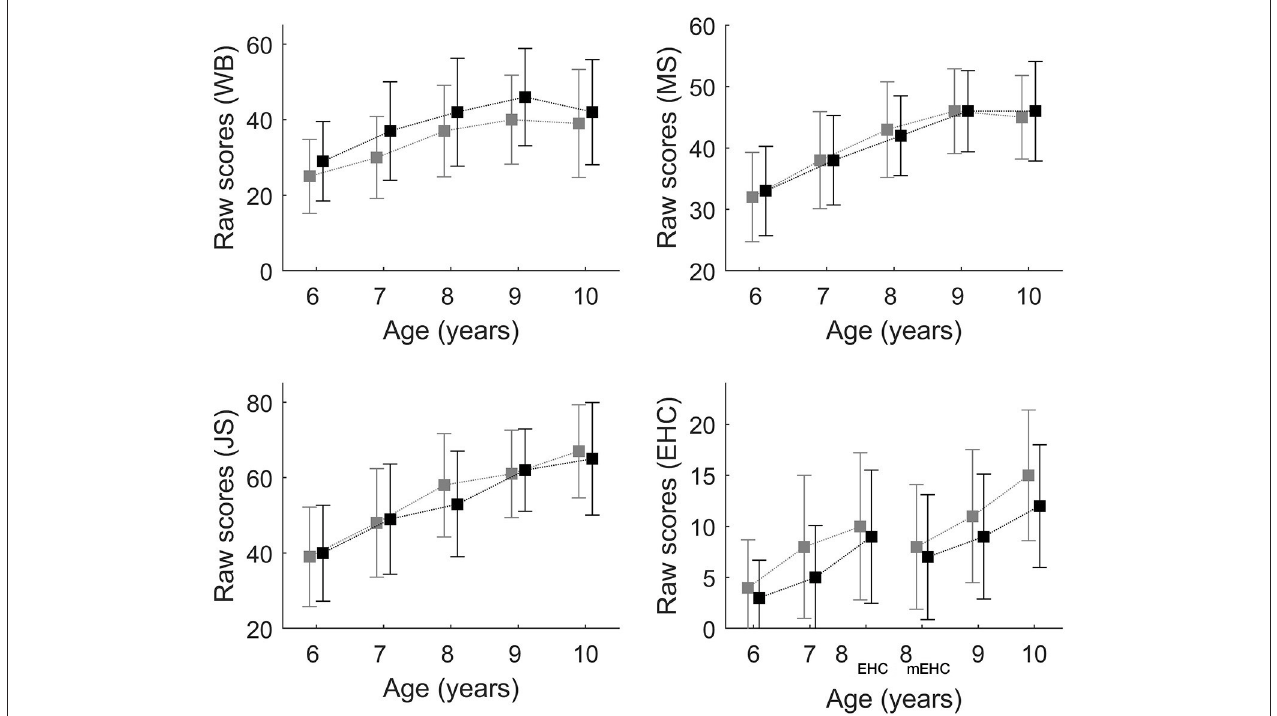
FIGURE 1 | Raw scores of the four test items for boys (gray line) and girls (dark line) per age.